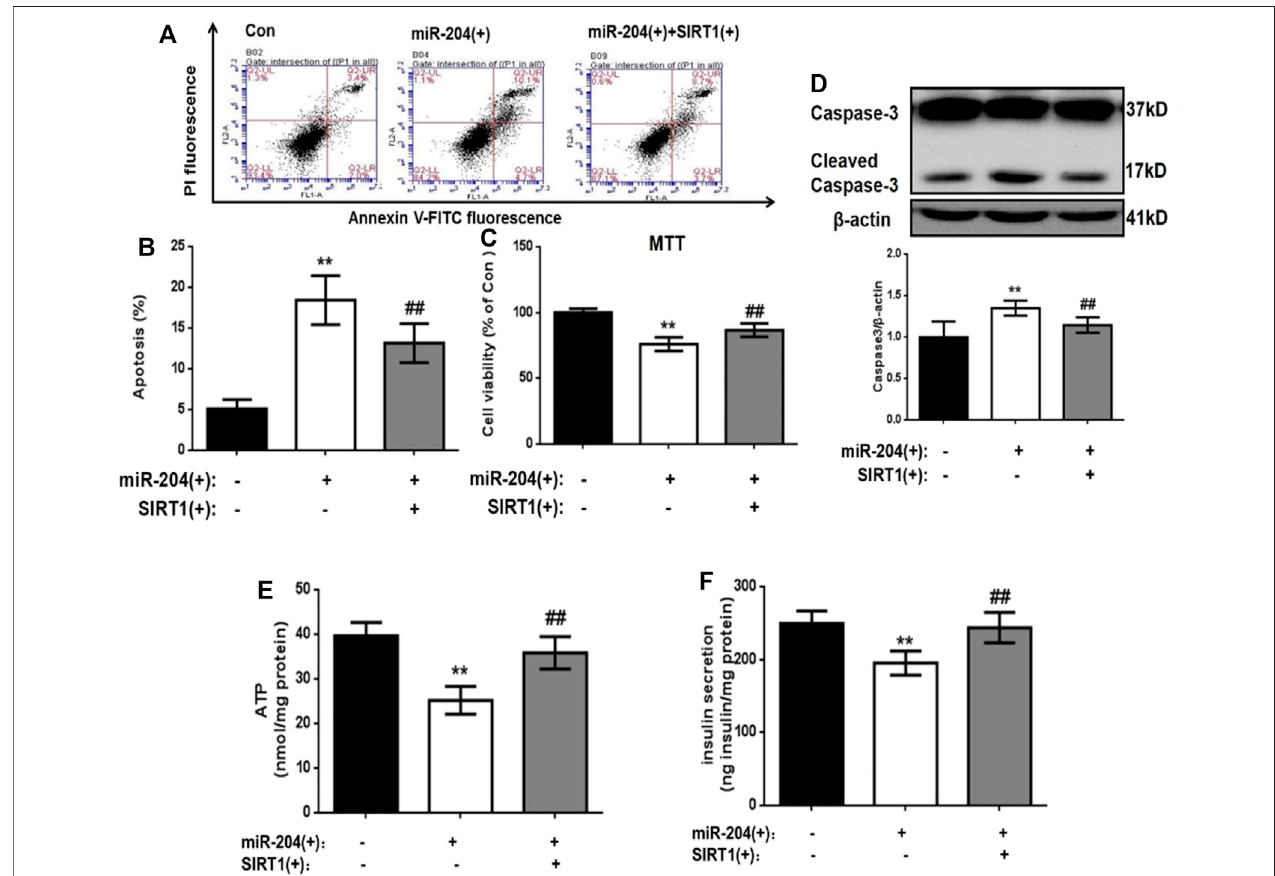
FIGURE 5 | . Effects of overexpression of miR-204 and SIRT1 on apoptosis and insulin secretion of MIN6 cells. (A, B) After miR-204 overexpression or miR-204 combined with SIRT1 overexpression was given to MIN6 islet cells, the apoptosis was detected and analyzed by fl ow cytometry. Data was expressed as means ± SEM ( n (cid:1) 6). ** p < 0.01, compared with control group; ## p < 0.01, compared with miR-204 (+) group. (C) The in fl uence of miR-204 overexpression and miR-204 combined withSIRT1overexpressiononthesurvivalrateofMIN6cellswereassessedbyMTTassay.Datawasexpressedasmeans ± SEM( n (cid:1) 6).** p < 0.01,comparedwith control group; ## p < 0.01, compared with miR-204 (+) group. (D) The protein was extracted from cells and caspase3 were measured by Western Blot. Data was expressed asmeans ± SEM( n (cid:1) 3).** p < 0.01,comparedwithcontrolgroup; ## p < 0.01,comparedwithmiR-204(+)group. (E) ATPconcentrationinthesupernatantof MIN6cellswasdetected.Datawasexpressedasmeans ± SEM( n (cid:1) 6).** p < 0.01,comparedwithcontrolgroup; ## p < 0.01,comparedwithmiR-204(+)group. (F) Basal insulin release and content were measured in MIN6. Data was expressed as means ± SEM ( n (cid:1) 6). ** p < 0.01, compared with control group; ## p < 0.01, compared with miR-204 (+) group.